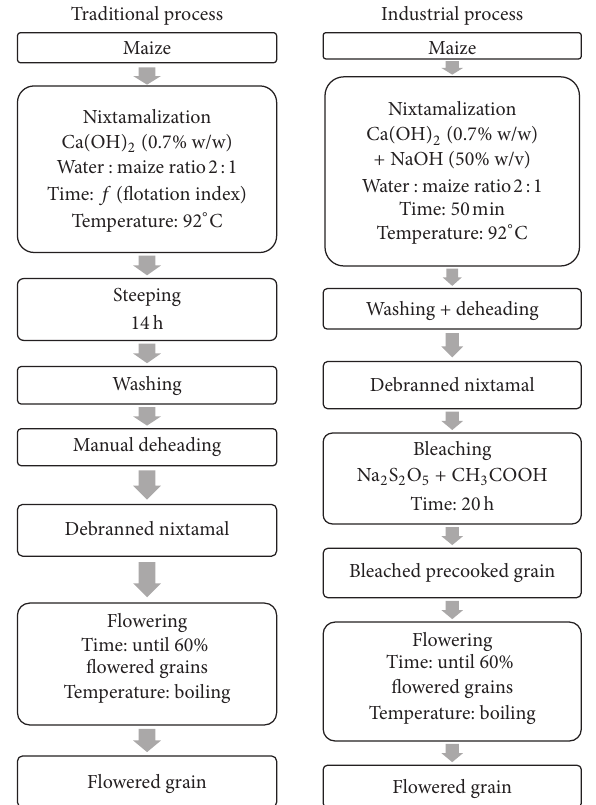
Figure 1: Summarized outlines of traditional and industrial pro- cesses to obtain flowered grain for pozole